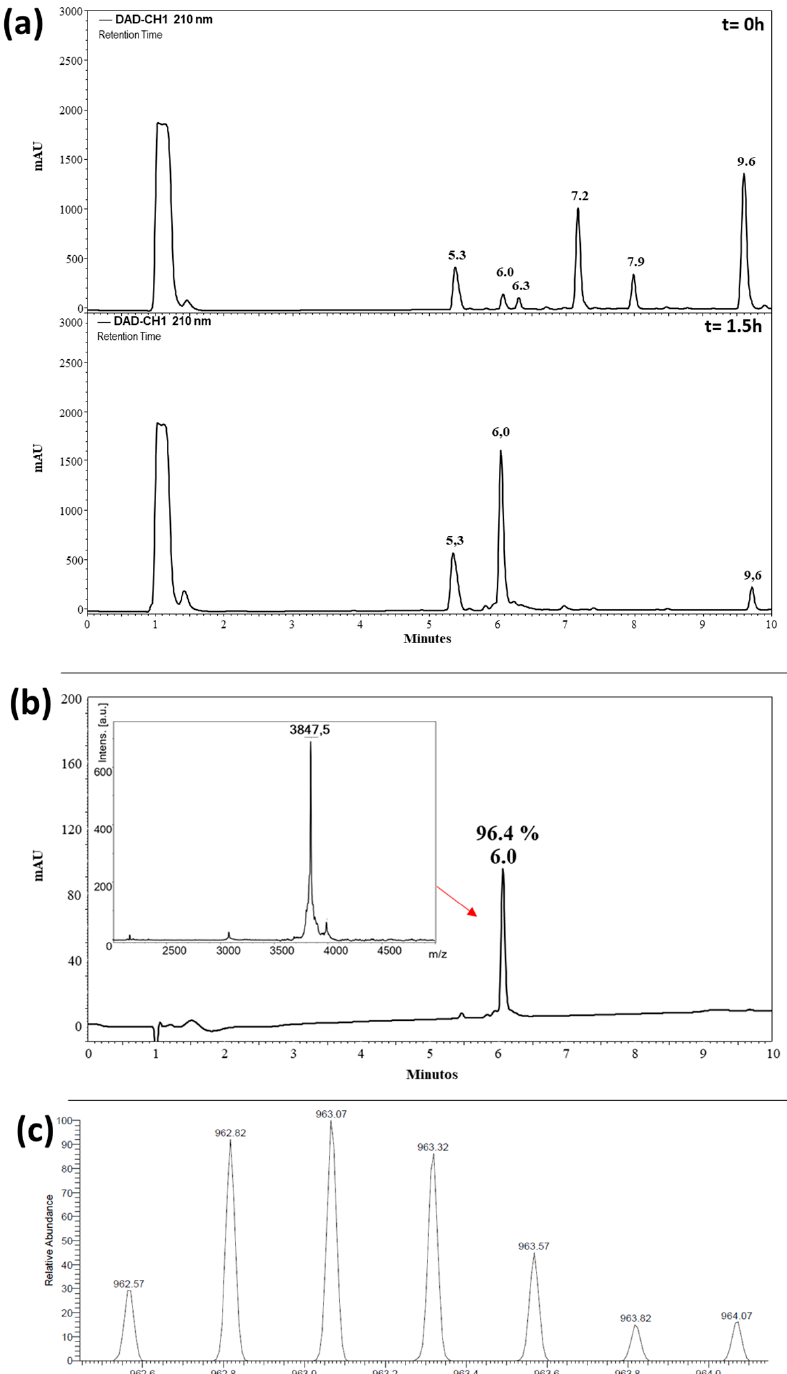
Figure 4. Click reaction between azide-peptide, K(N 3 )-RLLR (t R : 5.3 min) and the alkynyl-resorcin- arene CTpH(F), ( rctt, t R : 9.6 min). ( a ) Reaction monitoring by means of RP-HPLC at time 0 and 1.5 h. ( b ) Chromatographic profile, and MALDI-TOF MS spectrum of purified conjugate: CTpH(F)-